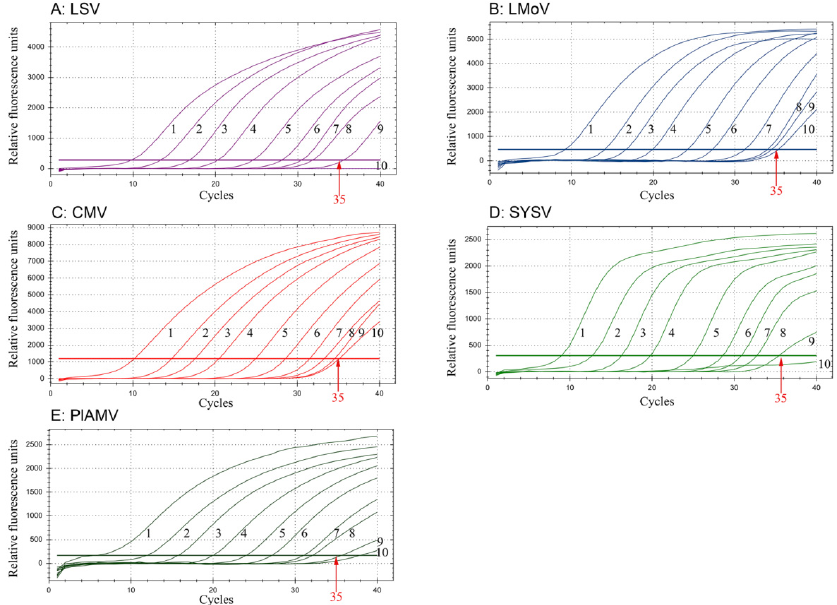
Figure 6. Sensitivity of the multiplex TaqMan real-time PCR assay for LSV ( A ), LMoV ( B ), CMV ( C ), SYSV ( D ), and PlAMV ( E ). 1–10, ten-fold serial dilutions of plasmid standard, with the concentrations from 1.33 × 10 9 to 1.33 × 10 0 copies·µL − 1 , 1.27 × 10 9 to 1.27 × 10 0 copies·µL − 1 , 1.28 × 10 9 to 1.28 × 10 0 copies·µL − 1 , 2.33 × 10 9 to 2.33 × 10 0 copies·µL − 1 , and 2.01 × 10 9 to 2.01 × 10 0 copies·µL − 1 for LSV, LMoV, CMV, SYSV, and PlAMV, respectively.